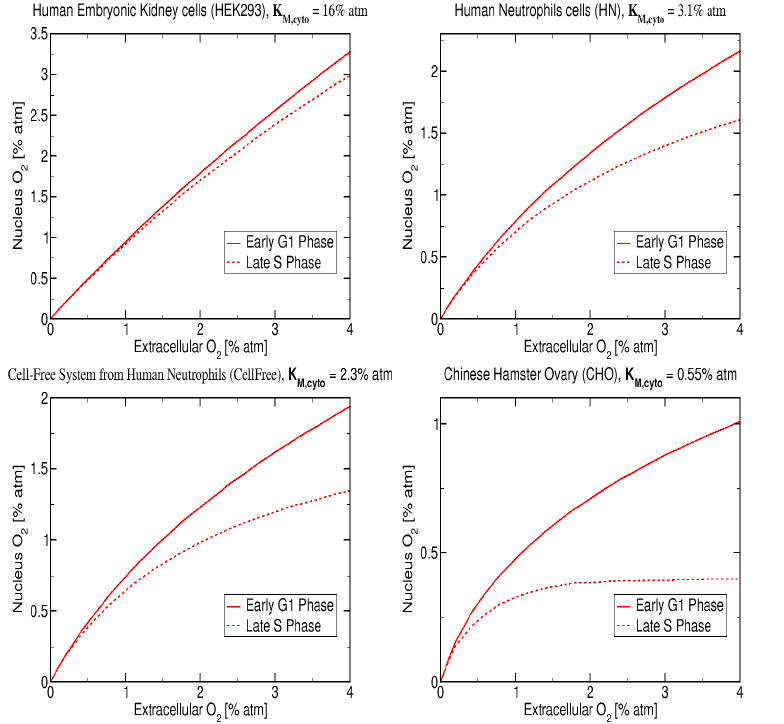
Figure 6. Model prediction for early G1 and late S phase and for four values of K M , cyto : 16% atm, 3.1% atm, 2.3% atm, 0.55% atm and cell lines: HEK, intact human neutrophils (HN), cell free